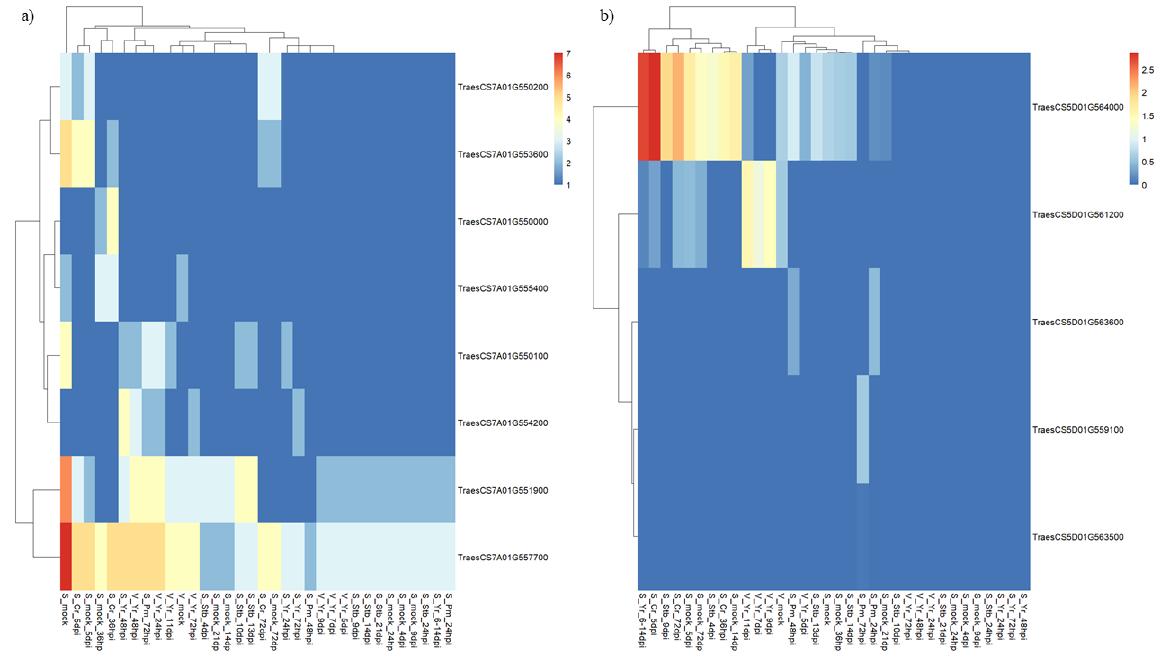
Figure 6. In silico expression analysis of selected candidate genes for powdery mildew ( a ) and leaf rust ( b ) resistance in response to biotic stresses in leaves and shoots. Seedling (S) and vegetative (V) developing stages are considered. Different time points, expressed as hour post inoculation (hpi) and days post inoculation (dpi), are indicated. Different diseases are considered: stripe rust (Yr), powdery mildew (Pm), crown rot (Cr), and septoria tritici blotch (Stb). The control condition is indicated as mock. Transcript abundances are expressed in log2 (tpm). Only genes whose expression profiles were available are reported. Data from Wheat Expression Browser (www.wheat-expression.com; accessed on 7 January 2021).